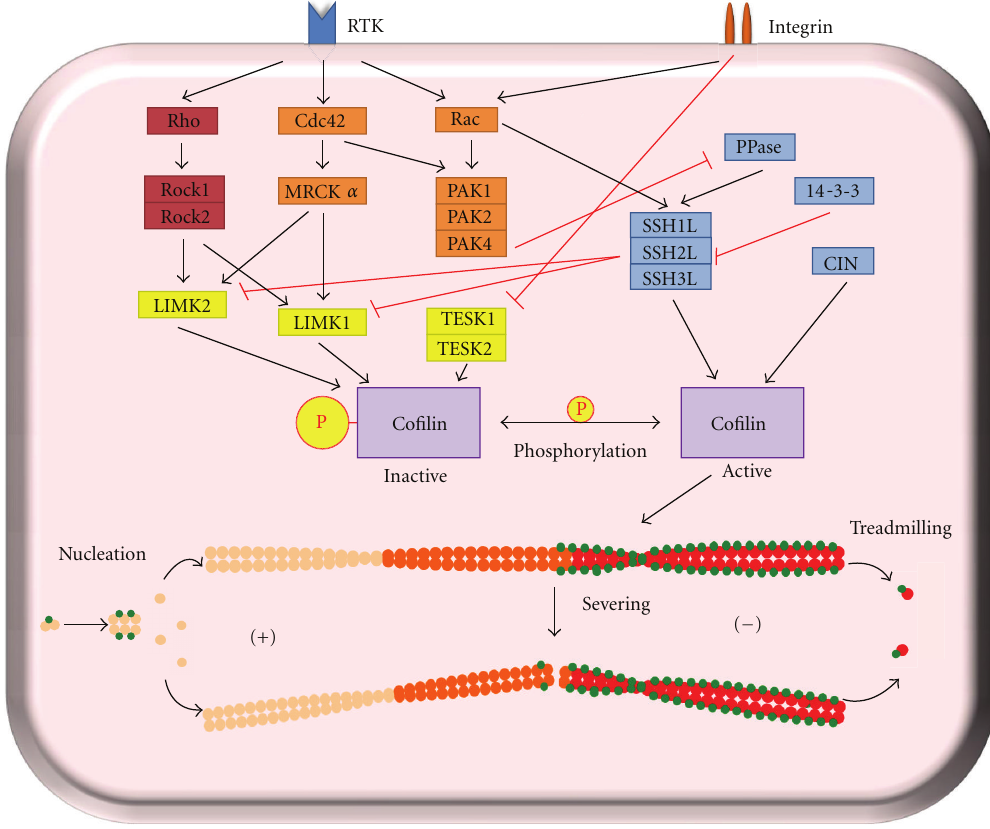
Figure 1: Regulatory pathways modulating cofilin phosphorylation and dephosphorylation Rho-GTPases are the predominant regulator of cofilin kinases and phosphatases. Cofilin phosphorylation is mainly regulated by LIMK and TESK. SSH family is the most important phosphatase that dephosphorylates cofilin directly or via LIMK inactivation. Phosphorylated cofilin can no longer bind and regulate the F-actin dynamics via treadmilling, severing, or